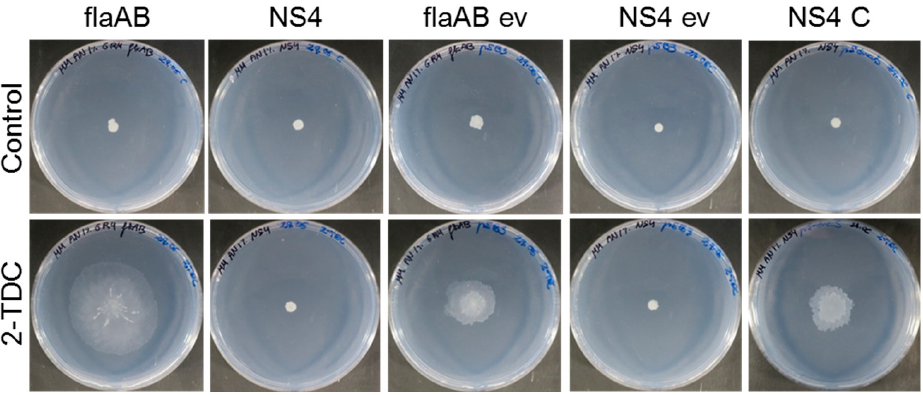
Figure 2. The inactivation of dnaJ in transposant NS4 is responsible for its insensitivity to 2-TDC. Surface motility assays on MM (1% agar) in the presence or absence of volatile 2-TDC. About 20 µL of either a solution containing 1 µmol 2-TDC or ethanol (Control) was applied to the lid of the plates just before incubation. flaAB, strain GR4flaAB; ev, empty vector pJB3; and C, complementing plasmid pJ-dnaJ. Representative pictures of the motilities exhibited after 48 h of incubation are shown. fl agellaless strain GR4 fl aAB and the wild-type strain GR4 ( fl aAB Δ dnaJ and G Δ dnaJ